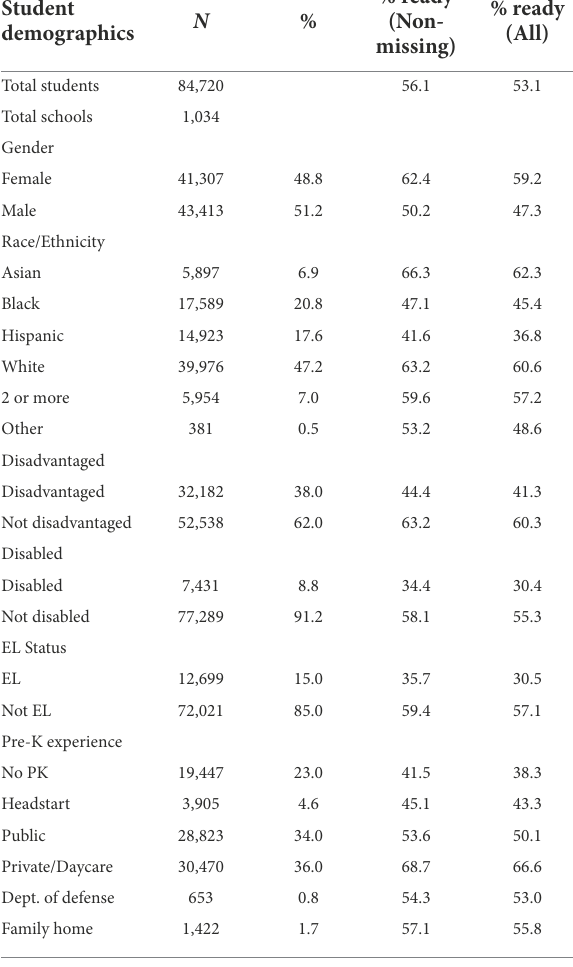
TABLE 3 School readiness rates by student demographic